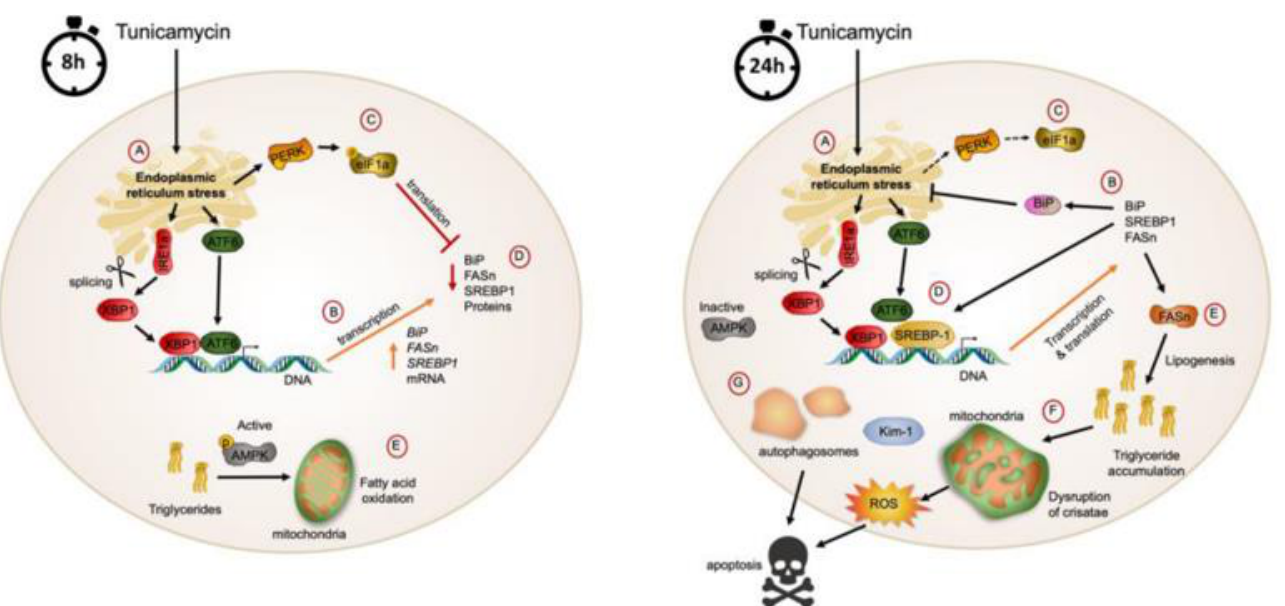
Figure 6. Altered metabolic pathways in response to ER stress in the kidney. Diagram representing the time-dependent role of endoplasmic reticulum stress in renal metabolic alterations. At 8 h (left) after administration, tunicamycin induces ER stress ( A ), increasing sliced XBP-1, BiP, SREBP-1 and FASn transcription ( B ). However, the inactivation of eIF2 α reduces general protein translation ( C , D ). At this time point, AMPK is still active and stimulates triglyceride hydrolysis and mitochondrial fatty acid oxidation ( E ). At 24 h (right), ER stress ( A ) augments BiP transcription and translation ( B ), reducing PERK-induced eIF2 α phosphorylation ( C ), increasing SREBP1 transcriptional activity ( D ) and FASn translation ( E ) along with a reduction in AMPK activity. As a result, renal lipid accumulation increases, leading to lipotoxicity and an impairment in the mitochondrial structure ( F ). Dysfunctional mitochondria increase the release of radical oxygen species, inducing cellular damage and activating Kim-1 which induces autophagy ( G ). However, excessive autophagy leads to apoptosis and a reduction in renal function.